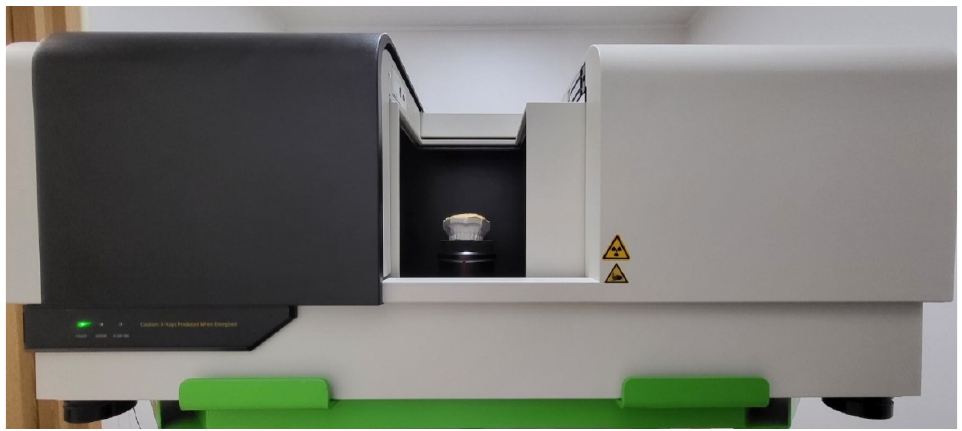
Figure 1. The micro-CT used for the experiment. The rotating stage can be moved vertically to adjust the cone-beam angle of the ray passing through the center of the object.